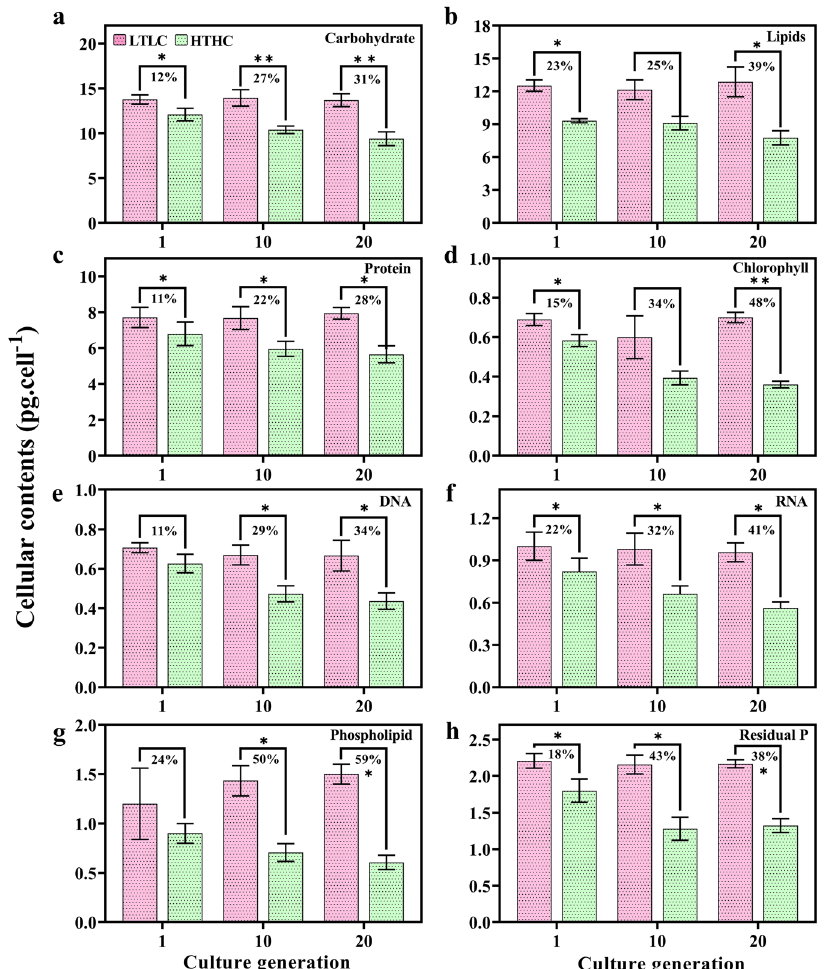
Fig. 3 Variation in the macro (carbohydrate, lipid, and protein) and minor (chlorophyll, DNA, RNA, phospholipid, and residual phosphorus) molecular content in Heterosigma akashiwo grown to different generations under LTLC and HTHC conditions. a carbohydrate ( b ) lipids, ( c ) protein ( d ) chlorophyll ( e ) DNA ( f ) RNA ( g ) phospholipid and ( h ) residual P. The percentages indicate comparison values between LTLC and HTHC samples. Signi fi cant differences for each parameter relative to the control are denoted by ∗ p < 0.05 and ∗∗ p <